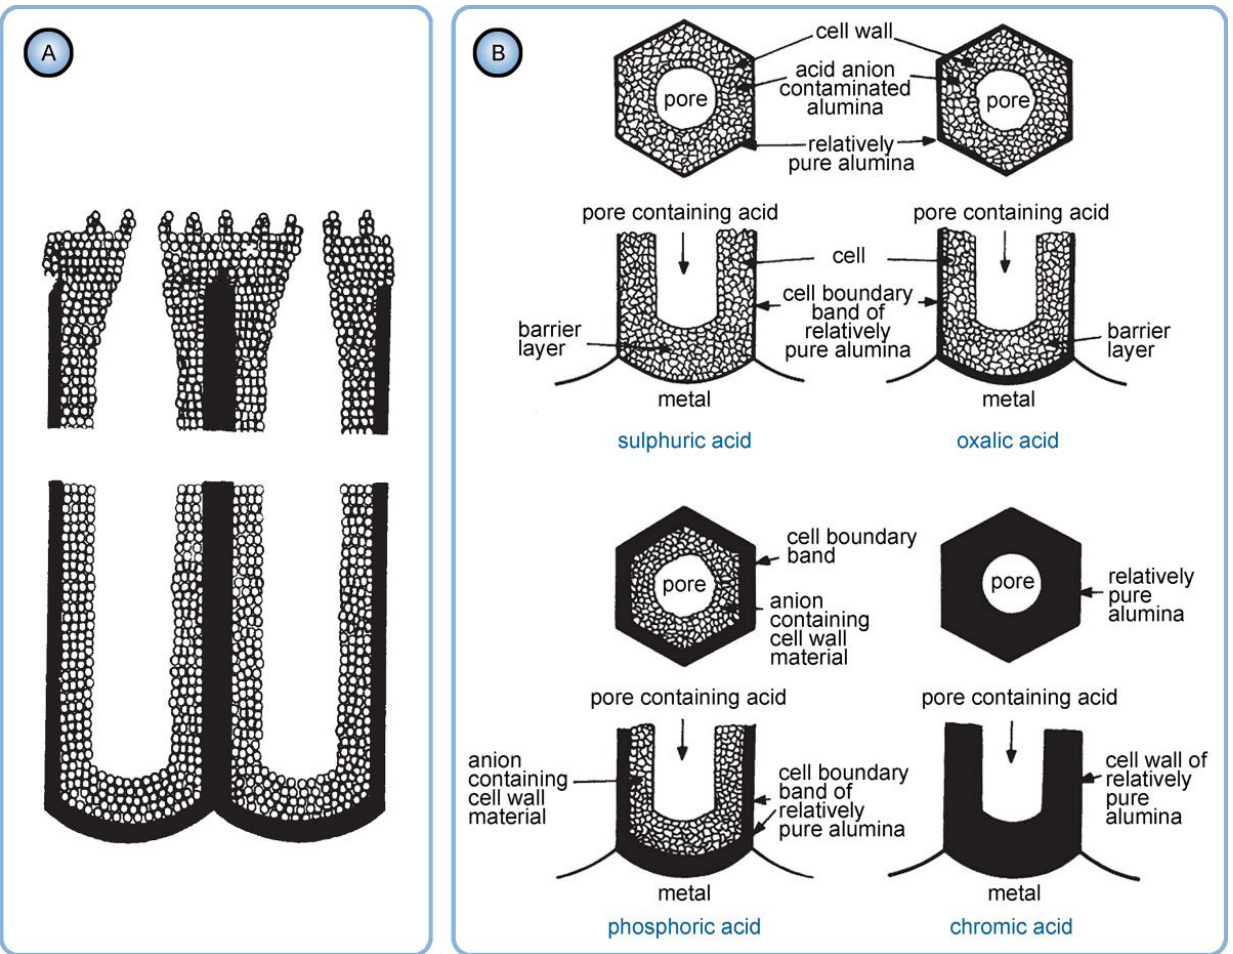
Figure 14. ( A ) A schematic depiction of PAA cells composed of relatively pure alumina and nanocrystalline material containing incorporated electrolyte anions (the morphology suggested by Thompson et al.). ( B ) The use of the model proposed by Thompson et al. for the explanation of different anionic contamination levels in PAA formed in the major used electrolytes (by considering different thicknesses of the polycrystalline anion-contaminated regions adjacent to the pore interiors). The assumed size of crystallites is <2.5 nm. Reproduced with permissions from [113,114]. Copyright 1978 and 1981 Nature.